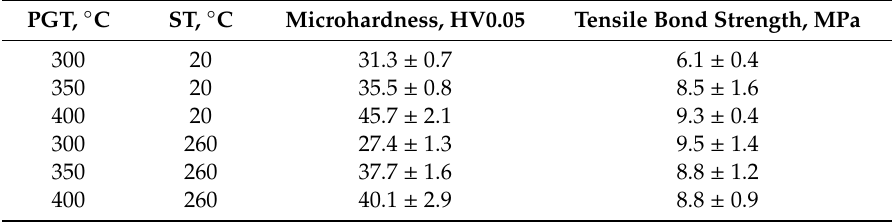
Table 1. Variation of preheating gas temperature (PGT) and substrate temperature